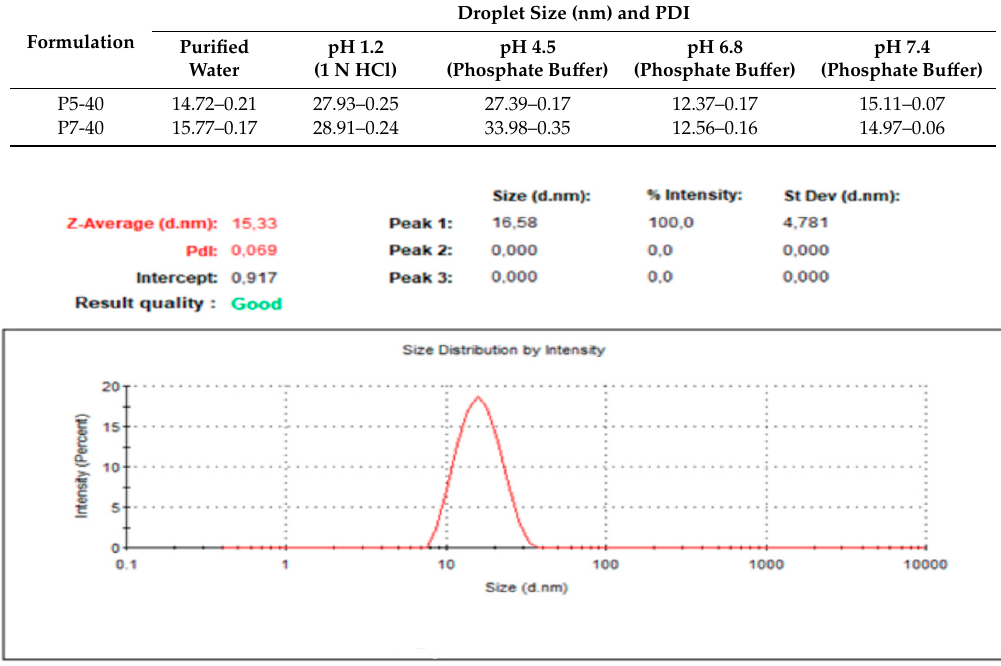
Figure 4. P5-40 formulation droplet size graphic reconstituted in distilled water.